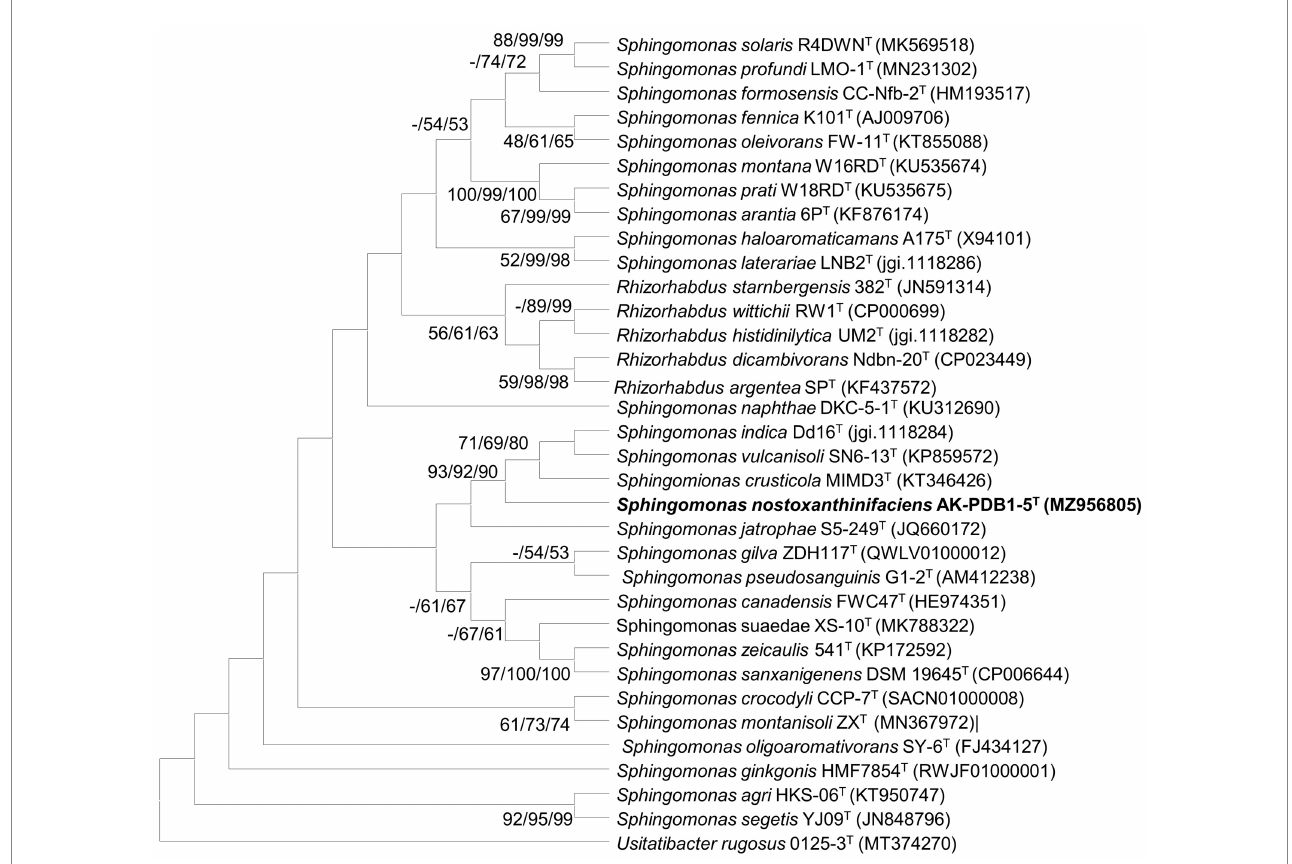
FIGURE 1 Maximum-likelihood (ML) algorithm phylogenetic tree based on 16S rRNA gene of strain AK-PDB1-5 T . Bootstrap values (> 70%) calculated using the NJ, ML, and ME algorithms are